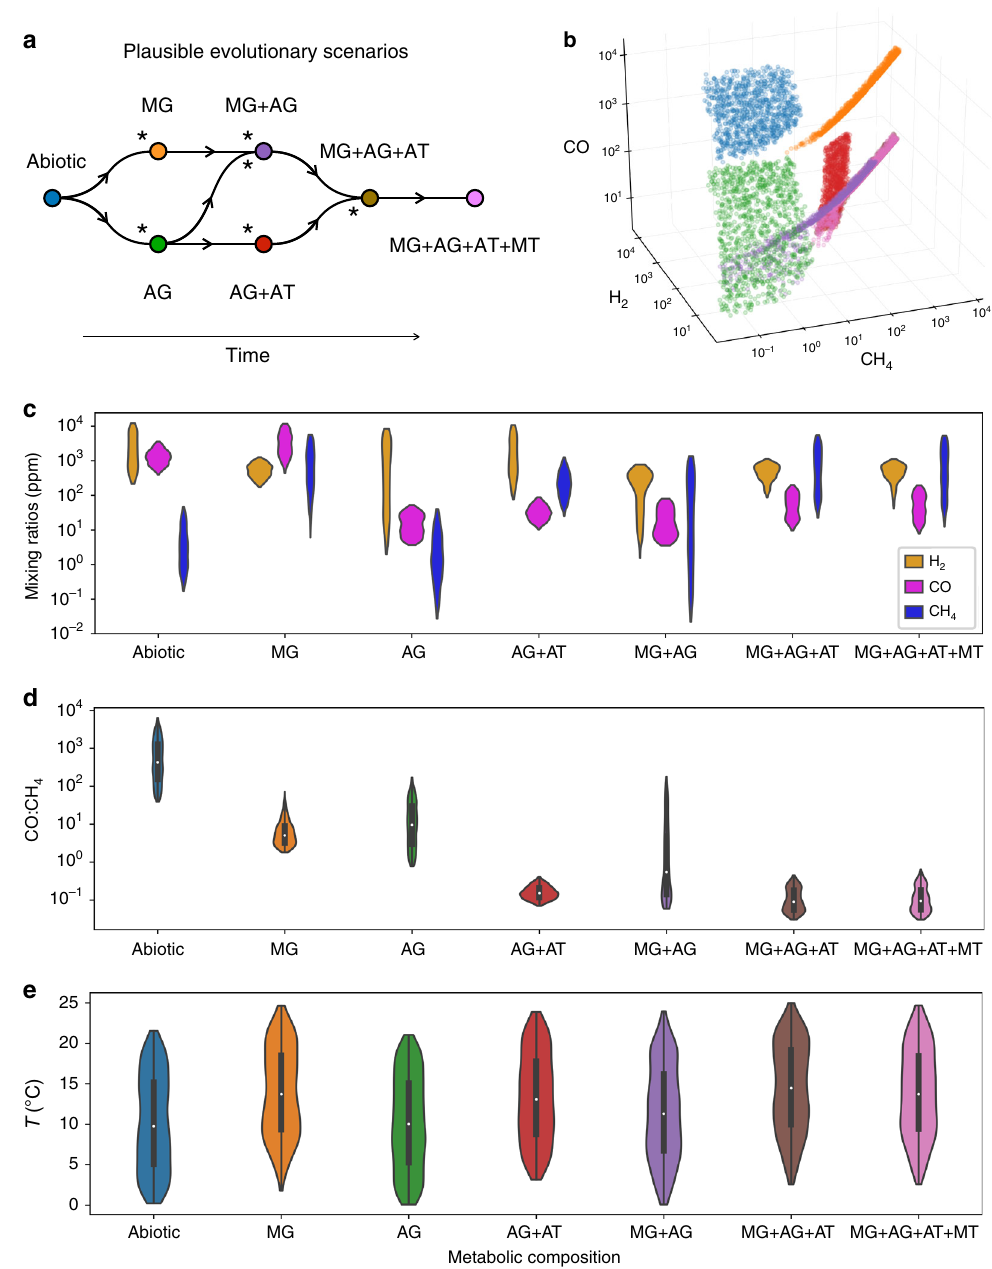
Fig. 4 Equilibrium state of the planet as the biosphere diversi fi es. a Plausible evolutionary sequences of metabolic innovation. Asterisks denote transitions that are very likely to cause a signi fi cant change in the atmospheric composition. b Scatterplot of the atmospheric compositions at equilibrium in CO, CH 4 , and H 2 , color-coded by the corresponding biosphere composition (1000 simulations for each ecosystem). c Corresponding distributions. d Distribution of the CO:CH 4 ratio for each scenario. e Distribution of the surface temperature in each scenario. The white dots in d , e represent the median of the distributions, the thick gray lines the interquartile range, and thin gray lines the rest of the distribution.